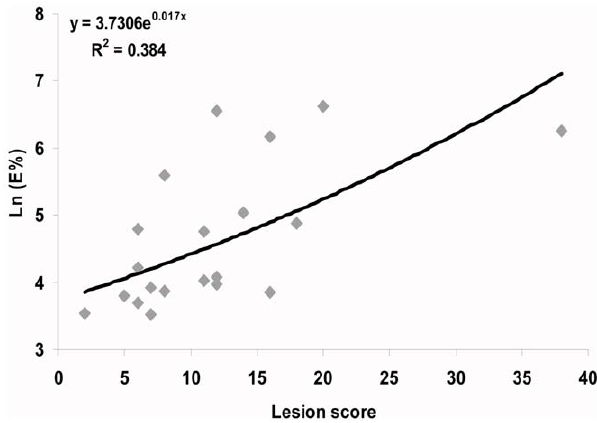
Figure 3. Relationship between antibody response and lesion scores. Relationship between the level of antibodies against bPPD in blood serum (E%) and the lesion scores of wild boar (n=20) experimentally challenged with Mycobacterium bovis . The regression equation and the coefficient of determination are shown in the chart.